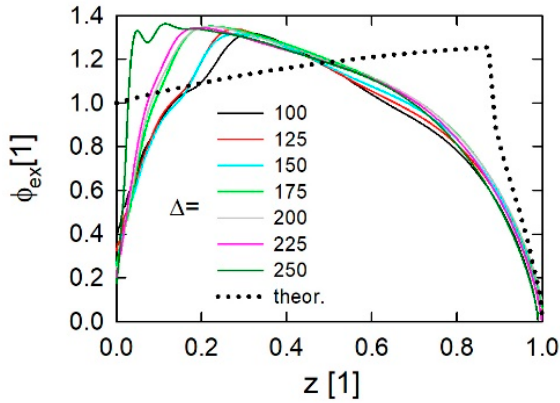
Figure 9. Plots of the experimental form–functions calculated using the mean θ 1 value.